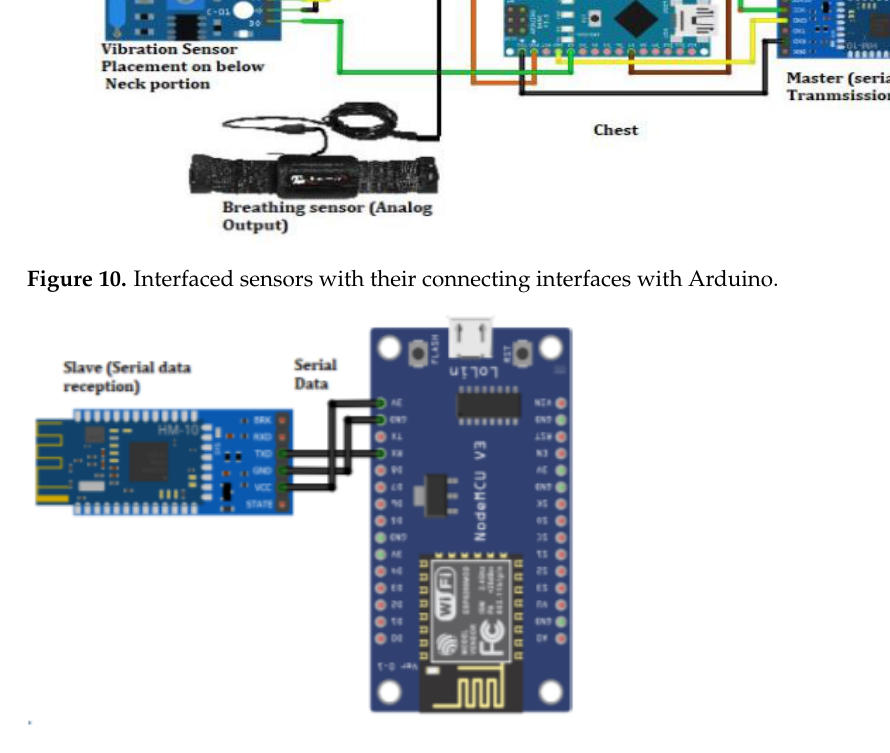
Figure 11. NodeMCU based Gateway for sensors data collection and enabling the IoT